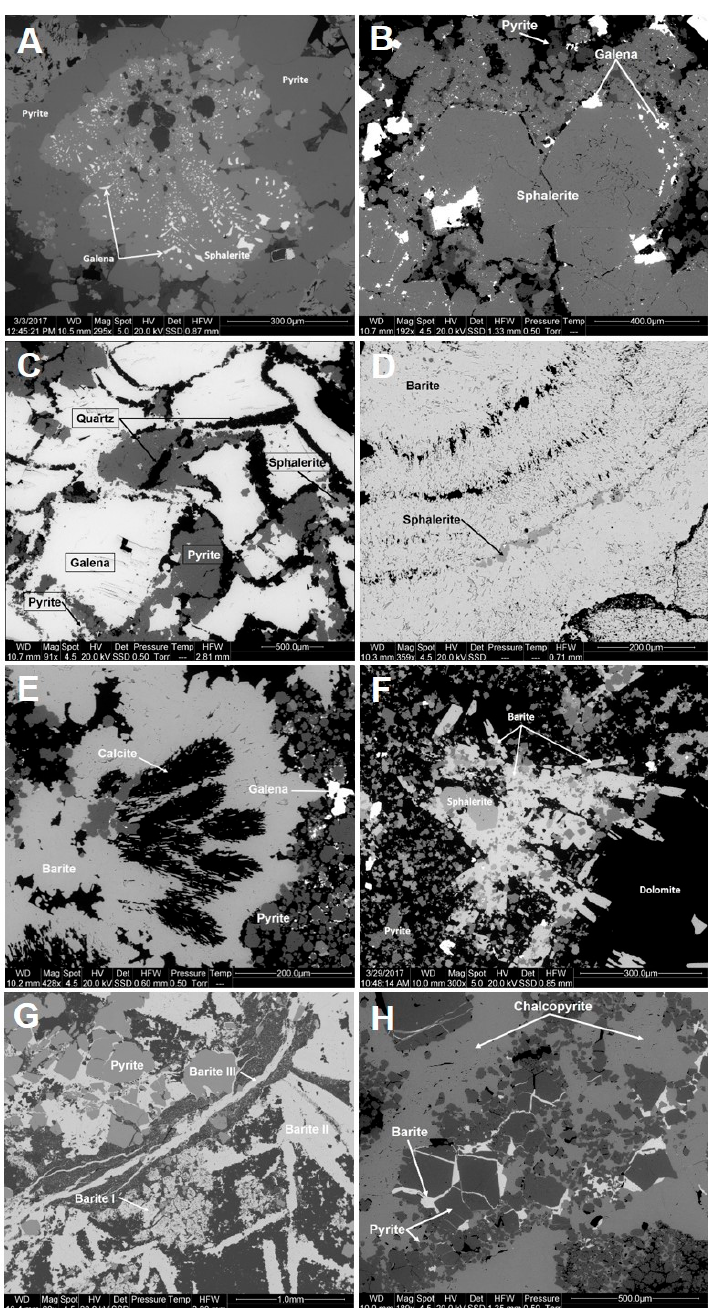
Figure 5. ( A ) Colloform sphalerite aggregate containing skeletal galena and surrounded by subhedral pyrite. Pyrite contains rounded, partially dissolved inclusions of sphalerite. ( B ) Subhedral, zoned crystals of sphalerite containing galena along growing planes and enveloped by a new generation of colloform sphalerite containing skeletal galena. ( C ) Remobilized galena containing partly dissolved remains of pyrite, sphalerite and quartz. ( D ) Barite bands made up of tabular crystals growing perpendicular to banding. Thin, discontinuous layers of sphalerite occur along bands boundaries. ( E ) Radial aggregates of tabular crystals of barite containing calcite nuclei. ( F ) Aggregate of tabular barite crystals containing abundant, rounded, partly dissolved inclusions of pyrite and sphalerite. ( G ) Different generations of barite superimposed on the same ore assemblage: early barite containing abundant inclusions of phyllosilicates and sulfides (Barite I), tabular barite (Barite II) and late, vein-filling barite (Barite III). ( H ) Chalcopyrite including cracked pyrite with barite filling some of the fractures. Note that chalcopyrite postdates barite.